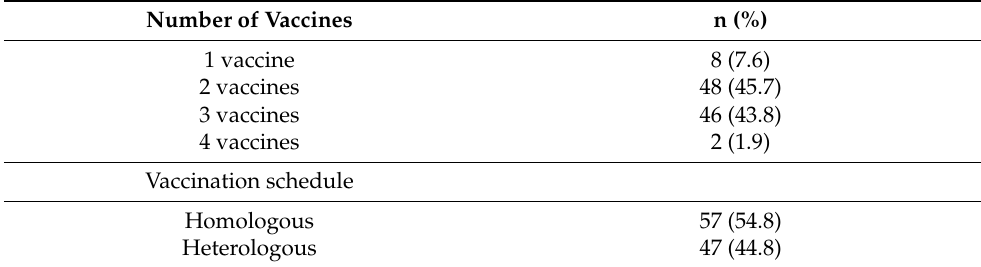
Table 2. Description of the vaccination